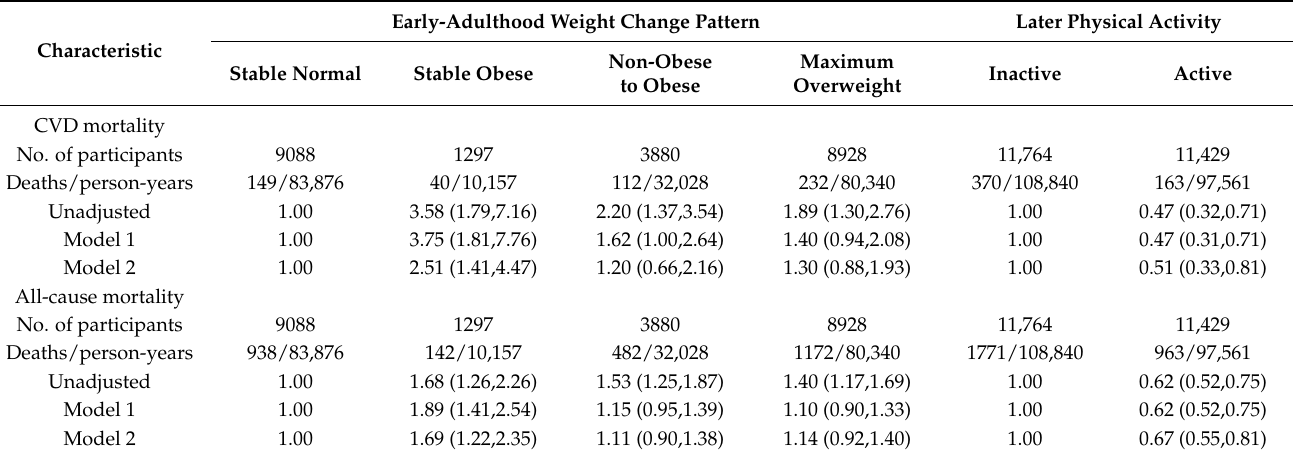
Table 2. Hazard ratios (95% CIs) of CVD and all-cause mortality according to early-adulthood weight change pattern and later physical